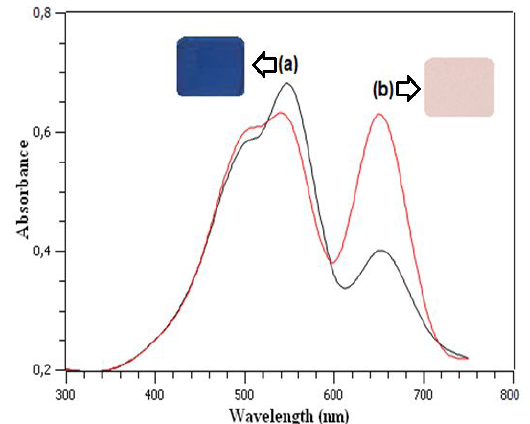
Figure 7. UV-VIS characterization of the thermochromism of the CoHo:PGLyD microspheres coatings at 25ºC (a)(—) and 60 ºC (b) ( ―